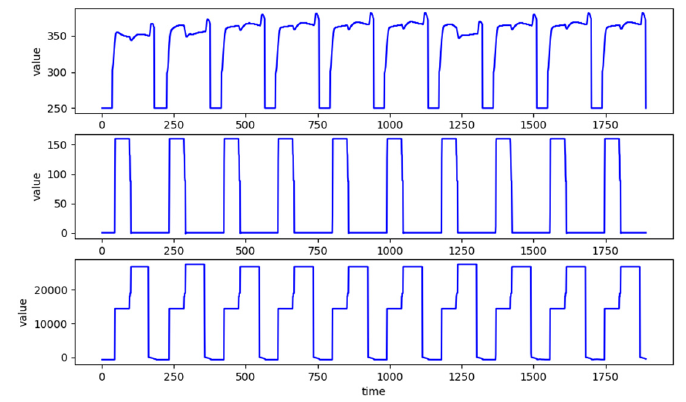
Figure 2. CS data containing 10 cycles from three SVIDs collected from an HDP-CVD tool.